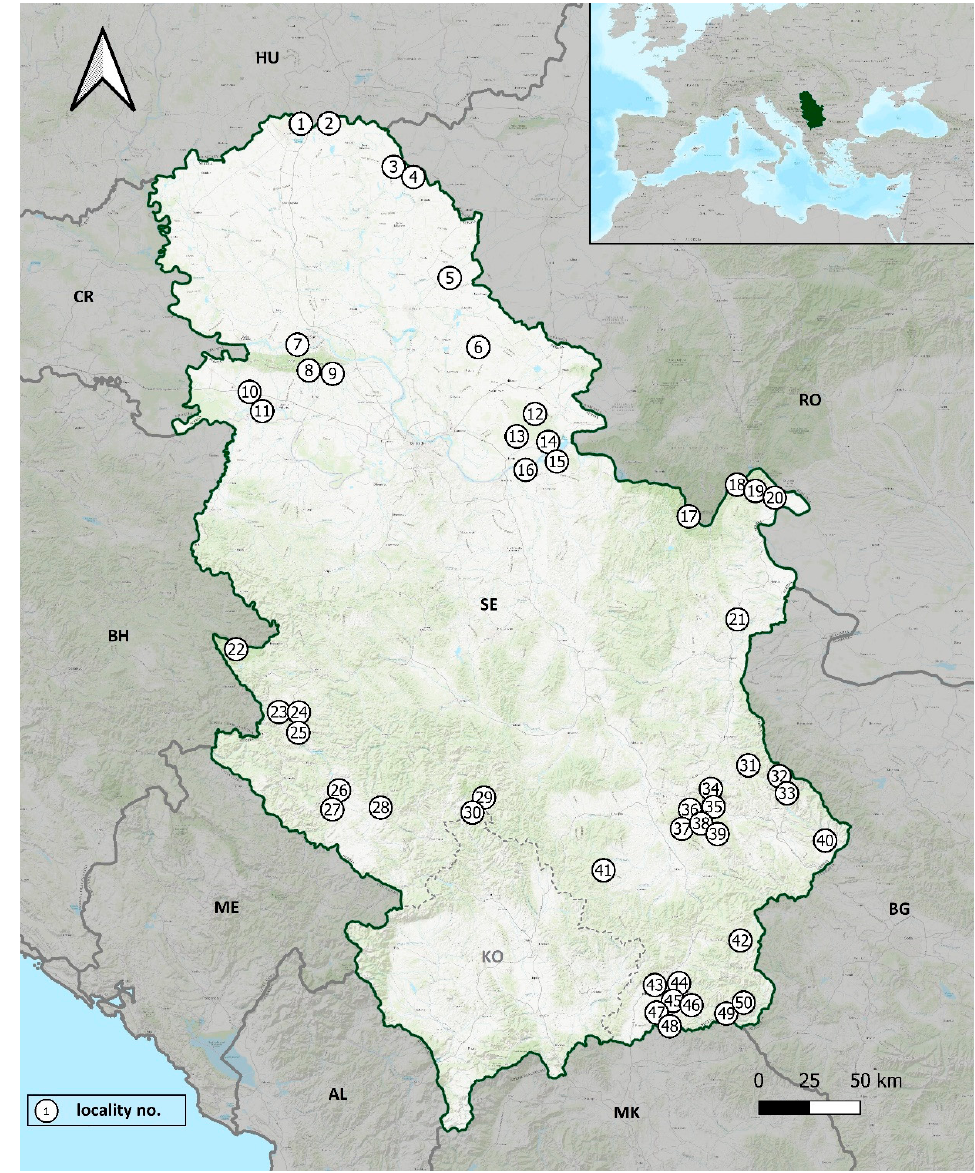
Figure 1. Collection localities of the scarabaeoid beetles in Serbia (2013, 2017–2019, 2021, 2022) (locality numbers correspond to those in Table 1).